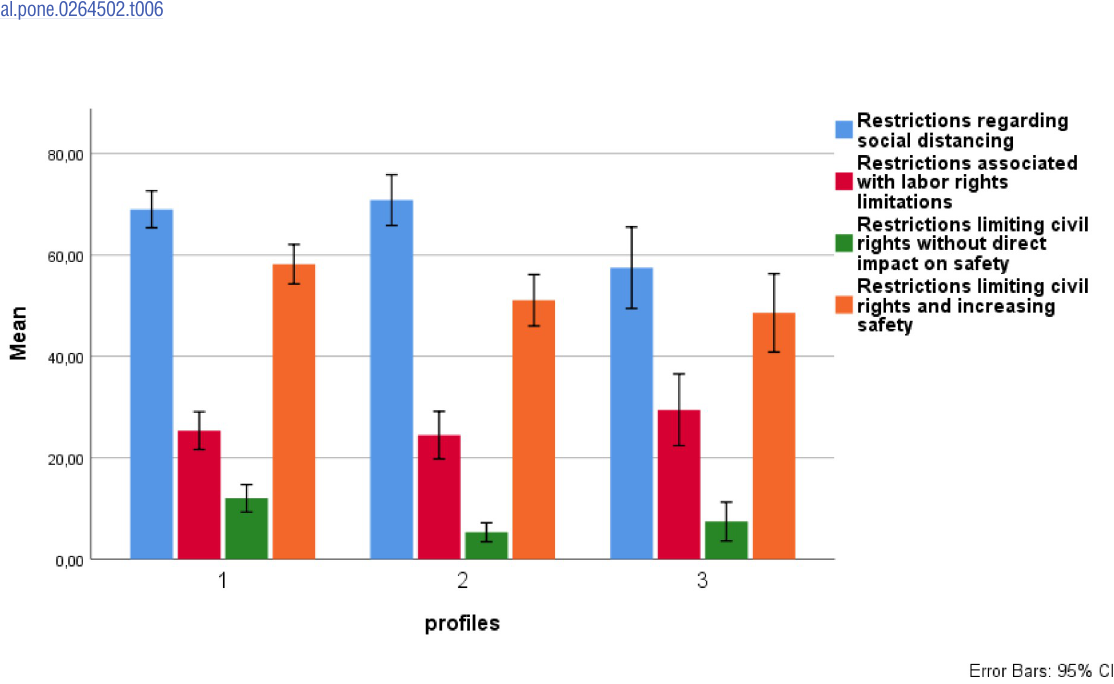
Fig 2. Mean values for the acceptance of four groups of pandemic restrictions for three latent